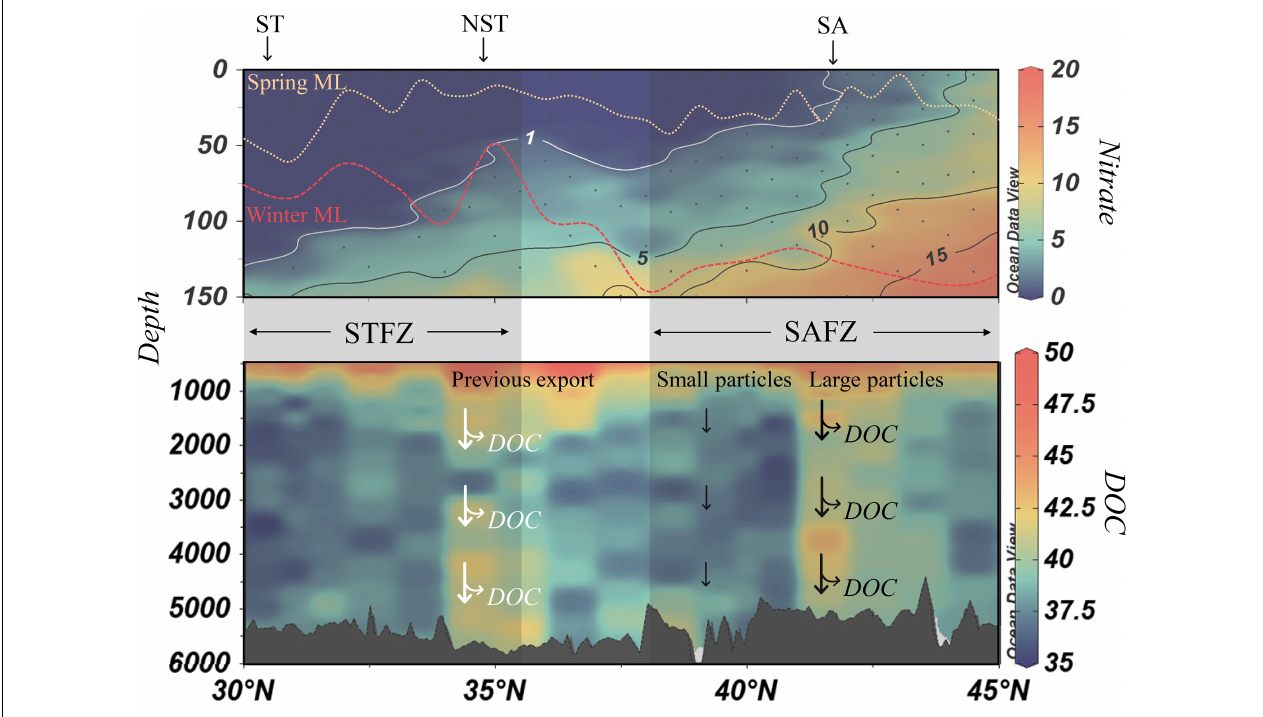
FIGURE 5 | Schematic of carbon export and controls within the transition zones (30–45 ◦ N). The distributions of observed DOC ( µ mol kg − 1 , > 500 m; lower panel) and nitrate ( µ mol kg − 1 , 0–150 m; top panel) are presented behind the schematic. The southern boundary of the nutricline is represented by the 1 µ mol kg − 1 nitrate isopleth (white contour). In winter, both the Northern Subtropical Front ( NST) and Subarctic Front (SA) experienced eutrophic conditions (i.e., nutricline was present above winter mixed layer depth; MLD; red dashed line). Particles exported to the bathypelagic beneath these fronts released DOC in their wake (bifurcating arrows; white arrows indicate winter export). Shoaling of the mixed layer from winter to spring (beige dashed line) shifted the latitude of the intersection of the mixed layer and the nutricline to the north. Though eutrophic conditions were experienced throughout the SAFZ, only the export of small particles that made no observable contributions to DOC at depth was observed (small black arrows), except beneath the SA . MLD was calculated as the depth at which potential density exceeded 0.125 kg m − 3 from the surface using CTD data. Winter ML was obtained from the 2006 P16N cruise using the same